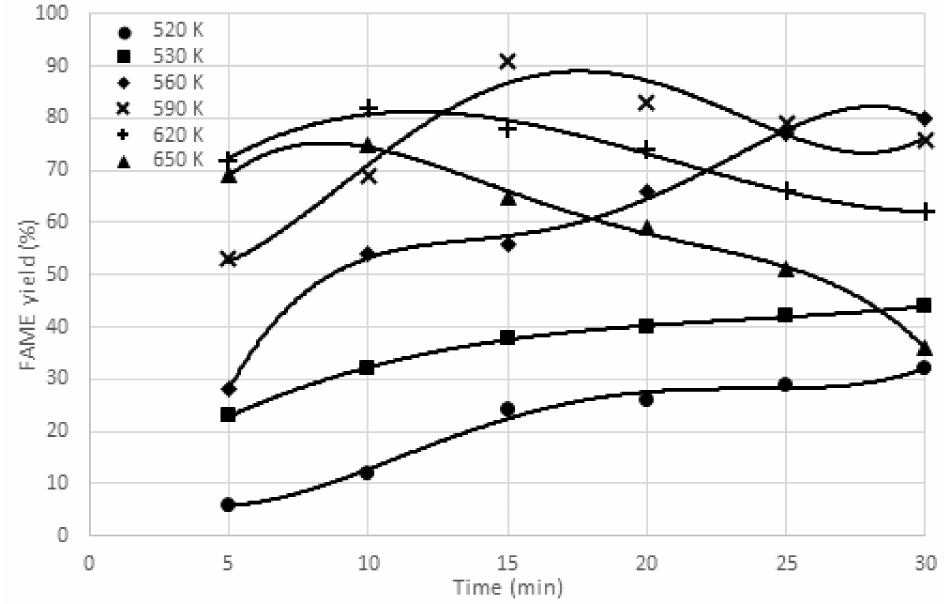
Figure 8. FAME yield (%) at variable reactor residence time (P = 351 bar and Molar ratio =